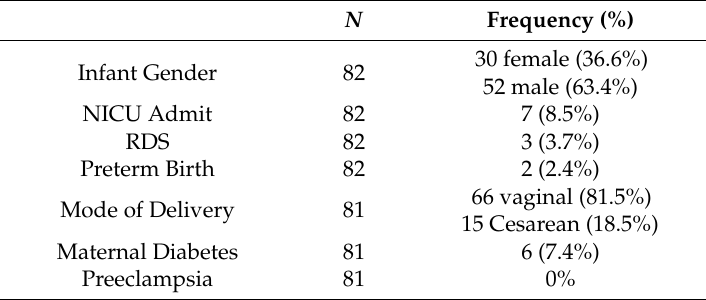
Table 2. Categorical responses of maternal and infant outcomes.